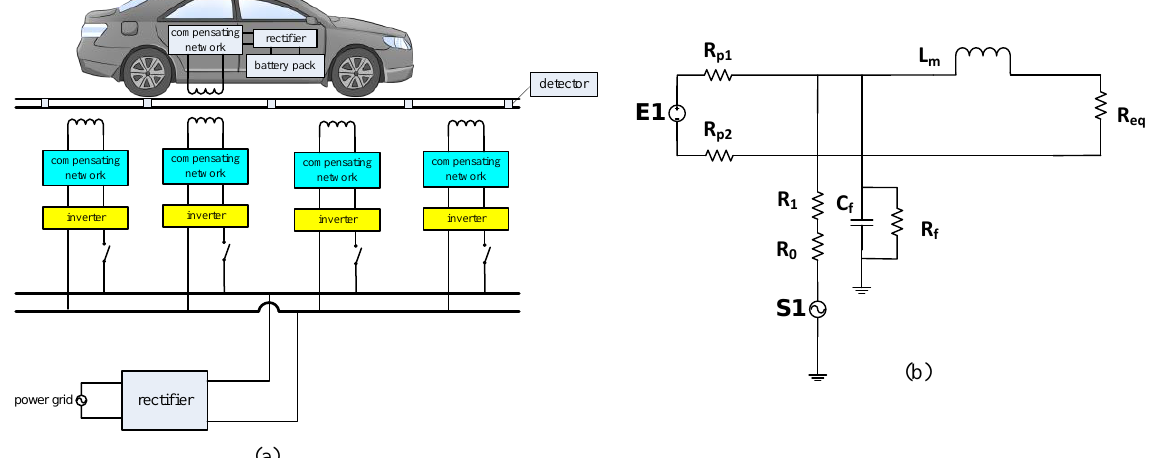
Figure 1. ( a ) Dynamic wireless charging network model for highway. ( b ) Calculation model of cable to ground insulation resistance in dynamic wireless charging network.